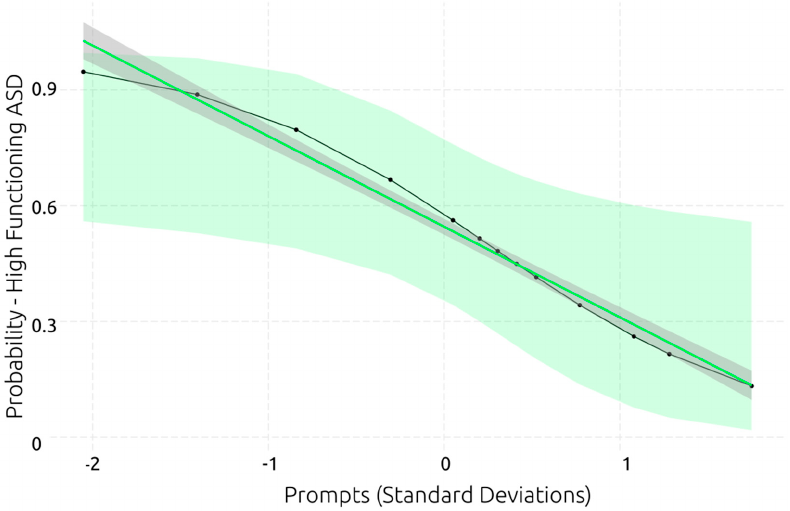
Table 6. Best generalised linear models for predicting ASD functionality level.